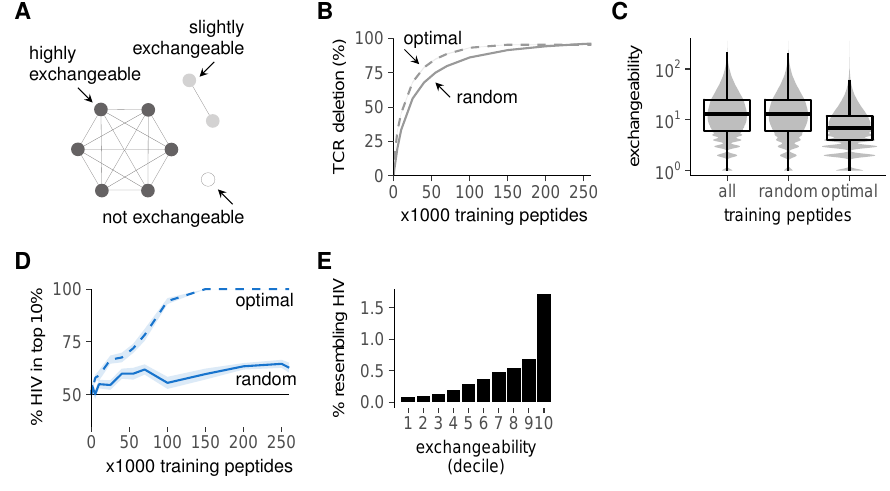
Figure 6. Improved self representation during negative selection allows self-foreign discrimination. ( A ) self peptides from large clusters delete the same TCRs as their neighbors and are thus exchangeable during negative selection, whereas peptides from small clusters are not; ( B ) percentage of self-reactive TCRs deleted by optimal training sets of self peptides during negative selection. TCR deletion with random training sets was computed on the data from Figure 5E for comparison; ( C ) peptide exchangeability distribution in the full set of all self peptides compared to that in random and optimal subsets of 100,000 peptides. Exchangeability is defined as the number of self neighbors + 1; ( D ) self-HIV discrimination after selection on optimal training sets. Discrimination after selection on random training sets (Figure 5D) is shown for comparison. See also Figure S4; ( E ) percentage of self peptides with HIV neighbor(s) plotted against exchangeability (self peptides were divided into 10 equal-number deciles from low to high exchangeability). Negative selection in panels b and d was performed with t = 4, and results were plotted as mean ± SEM of 30